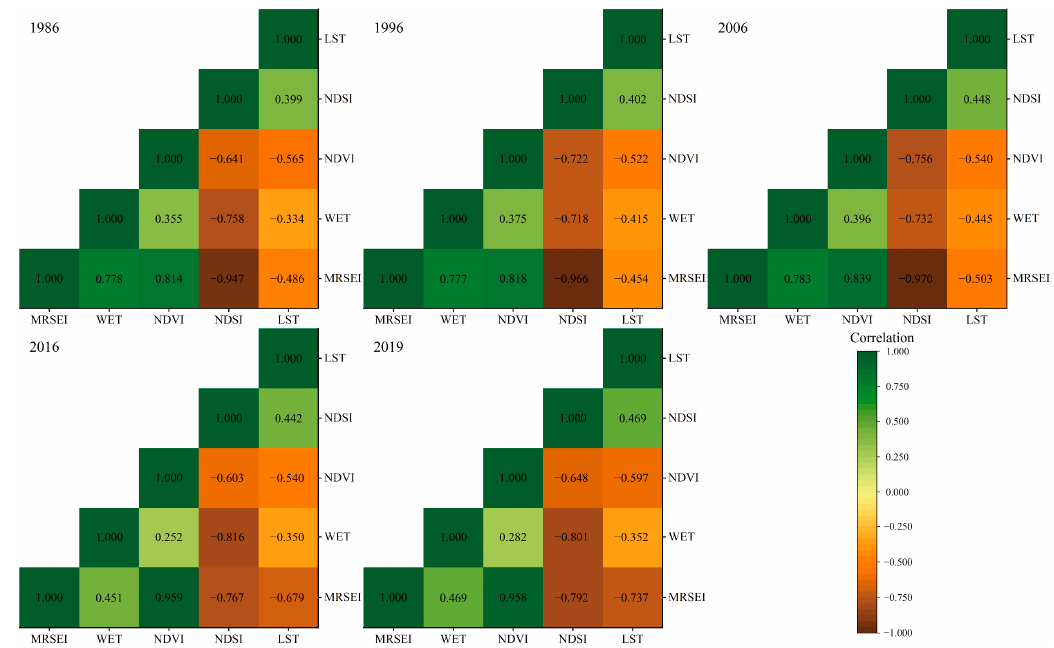
Figure 5. Correlation of MRSEI and ecological factors.